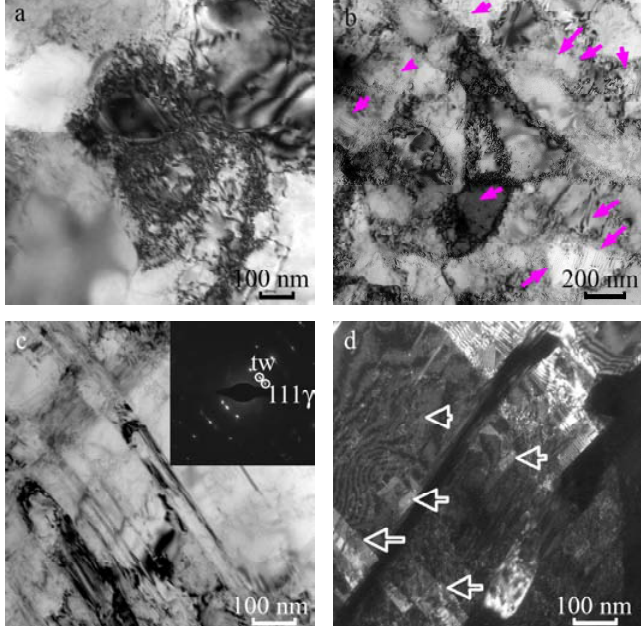
Fig. 9. Details of the microstructure in UFG-CrNiTi steel specimens: a – after ABC-pressing; b – after ABC- pressing and H-charging for 100 hours; c, d – after ABC-pressing, H-charging for 100 hours and tension. Arrows on images (b) and (d) show stacking faults. All images correspond to surface hydrogen-saturated